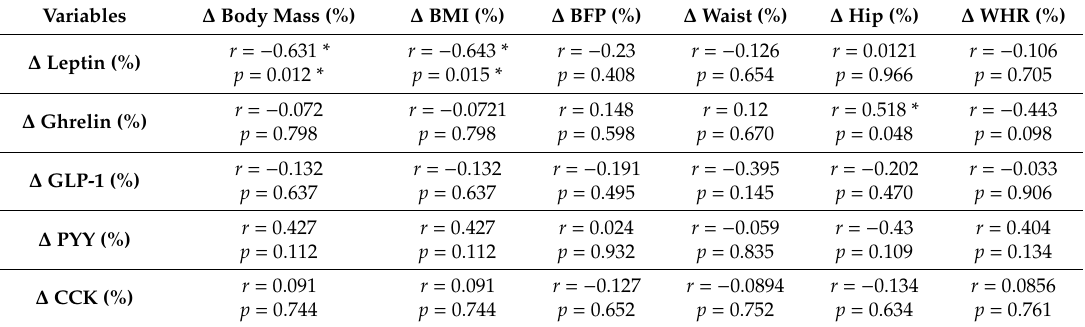
Table 4. Relationships between % changes of anthropometric measurements and gut hormones in experimental group ( n =